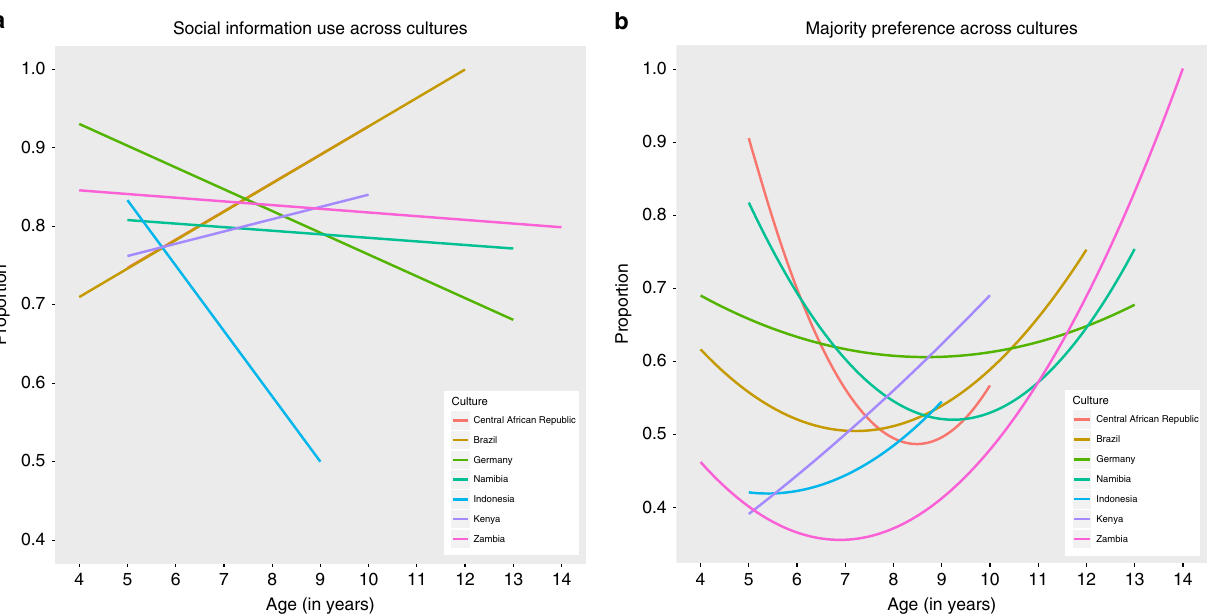
Fig. 2 Culture-speci fi c ontogenies of children ’ s social learning. Depicted are a children ’ s reliance on social information (vs. innovation), and b majority (vs. minority) preference, for each sampled culture. In a , n = 605, cultural diversity in social information use is represented by the differently valenced slopes across age (the slopes of Brazil and the Central African Republic in panel a almost perfectly overlap, see Supplementary Figure 1). In b , n = 475, cultural homogeneity in majority preference can be inferred from the similar U-shaped trajectories across age